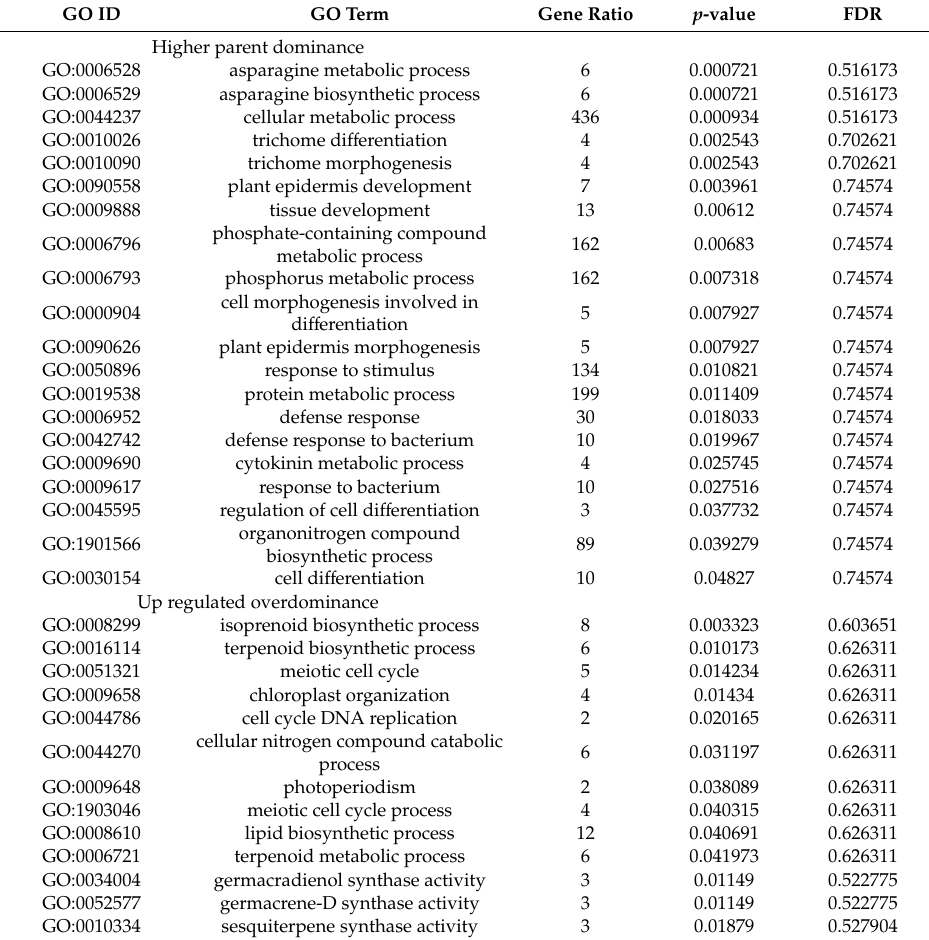
Table 4. GO analysis of DEGs involved in higher parent dominance and up regulated